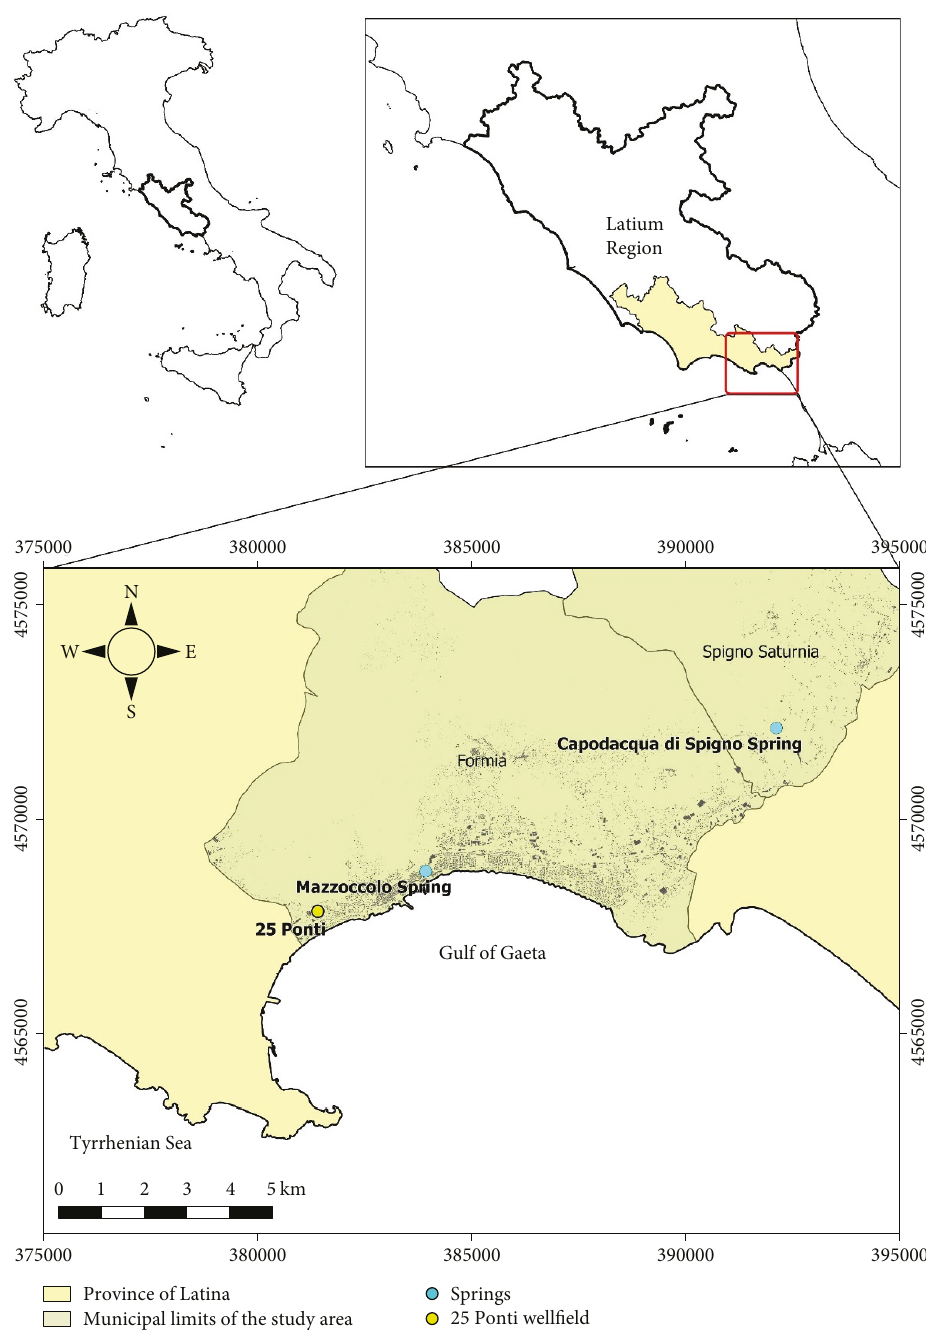
Figure 1: Geographical framework of the study